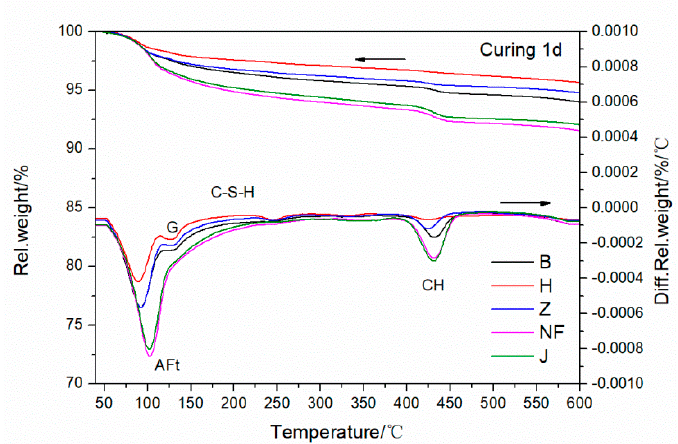
Figure 5. Effects of different superplasticizers on cement hydration after 1 day.